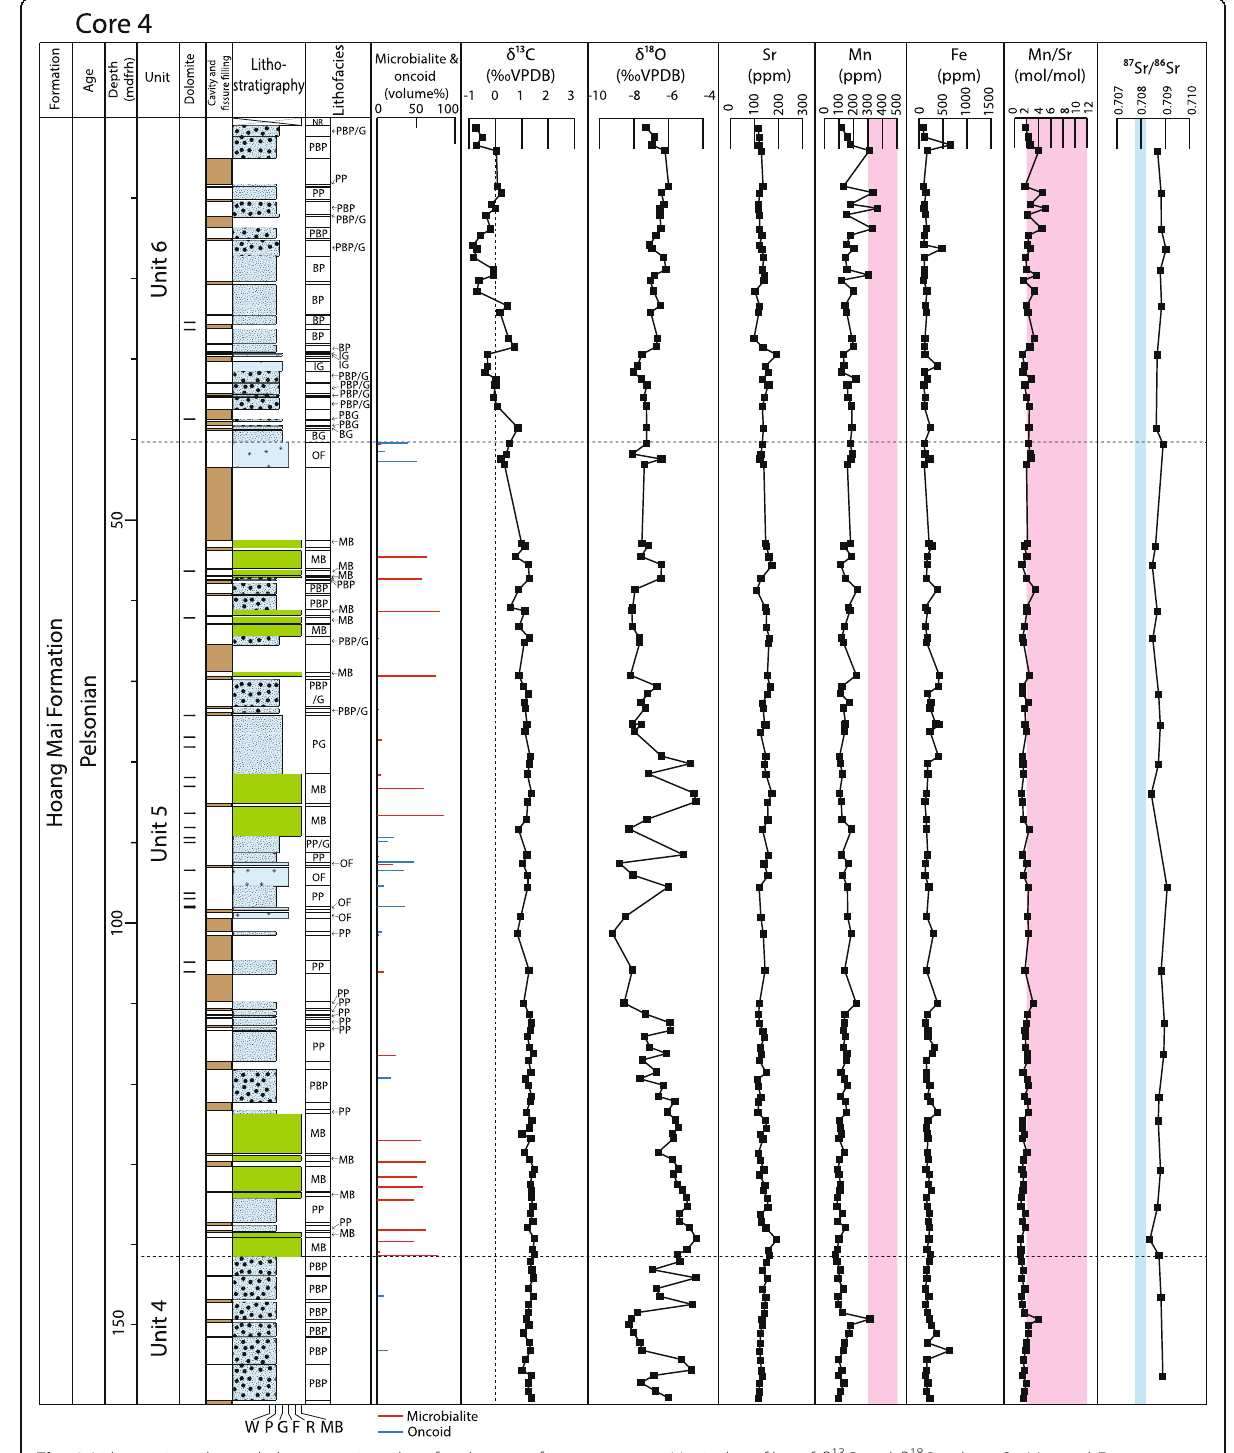
Fig. 3 Lithostratigraphy and chemostratigraphy of carbonates from core no. 4. Vertical profiles of δ 13 C and δ 18 O values, Sr, Mn, and Fe concentrations, and Mn/Sr and 87 Sr/ 86 Sr values of bulk carbonate samples from core no. 4. For the definition of the pink and blue areas and abbreviations, see the Fig. 2